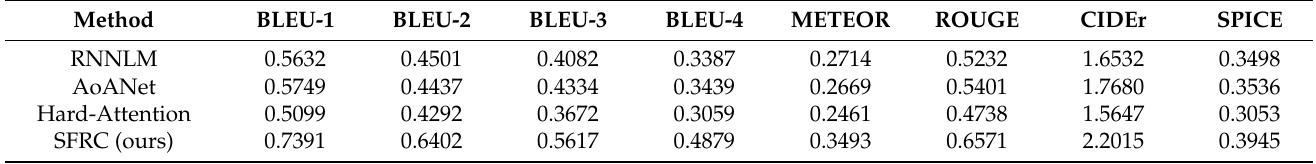
Table 9. Comparison of evaluation metric scores of methods on 60% RSICD dataset.